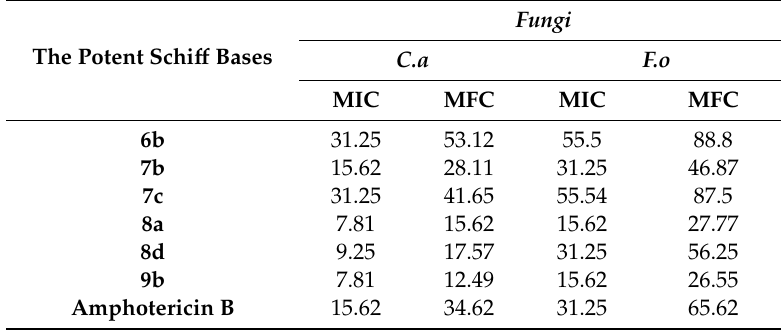
Table 3. Minimal inhibitory concentrations (MIC, µ g / mL) and the minimum fungicidal concentrations (MFC, µ g / mL) of the potent Schi ff bases against fungi